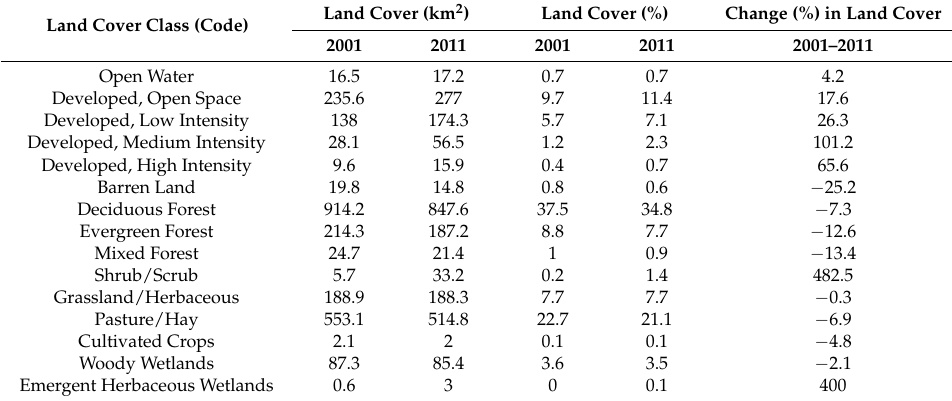
Table 1. Transition matrix showing the movement of land cover types (%) between 2001 and 2011 in the selected watershed.